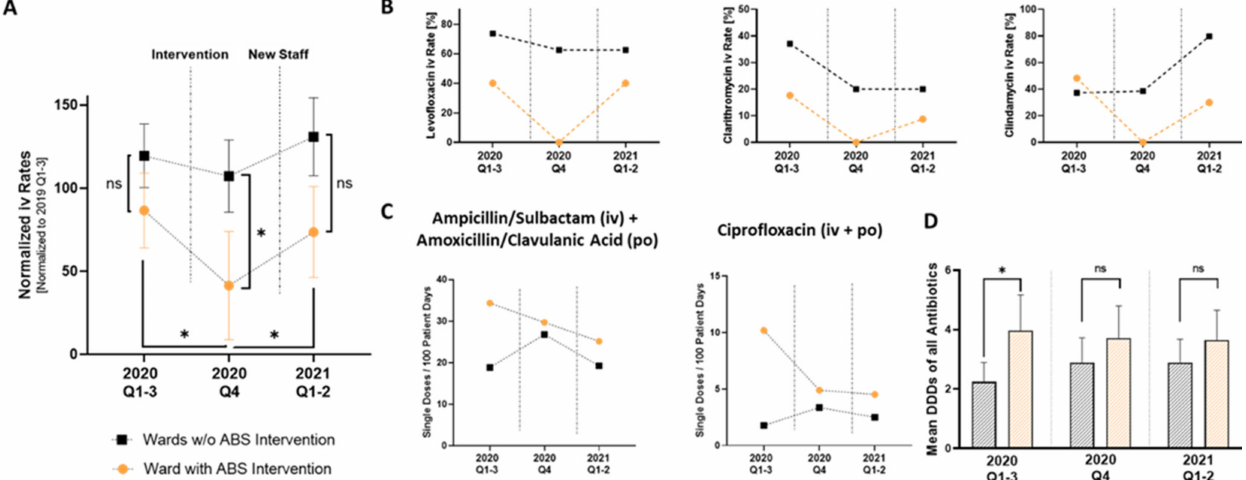
Figure 4. Lower iv percentages of total DDDs were driven by a total reduction in iv Levofloxacin, iv Clindamycin, and iv Clarithromycin use. ( A ) Normalized iv rates of all DDD of Levofloxacin, Ciprofloxacin, Clindamycin, Ampicillin/Clavulanic acid, and Ciprofloxacin on the ward, with and without ABS intervention (normalized to mean iv DDDs of Q1–3 2020 on all wards); n = 5 per group; paired t -test; * p < 0.05. ( B ) Mean iv rates of Levofloxacin, Clarithromycin, and Clindamycin ( n = 1 vs. 3; no statistics). ( C ) Combined iv and po single doses/100 patient days of Ampicillin/Sulbactam and Amoxicillin/Clavulanic acid and Ciprofloxacin ( n = 1 vs. 3; no statistics). ( D ) Time course of mean single doses of all antibiotics ( n = 29 per group; Wilcoxon matched pairs signed rank test; * p <